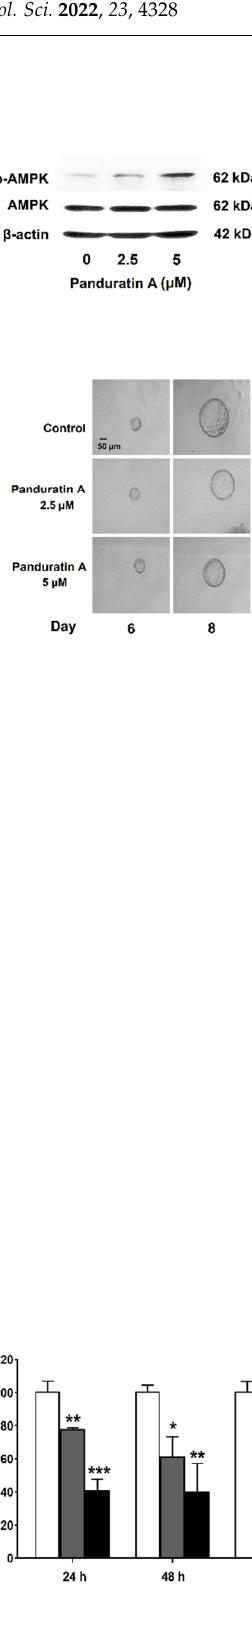
Figure 2. Effect of panduratin A on cell proliferation and intracellular protein signaling of cell proliferation markers in MDCK cells. ( A ) MDCK cells were treated with vehicle or 2.5 or 5 µ M panduratin A for 24, 48, and 72 h ( n = 3). ( B ) Representative and quantitative analysis of S6K and ERK expression in MDCK cells following 24 h treatment ( n = 5). Data are expressed as the mean of percentage control ± SD. * p < 0.05, ** p < 0.01, and *** p < 0.001 compared to control.